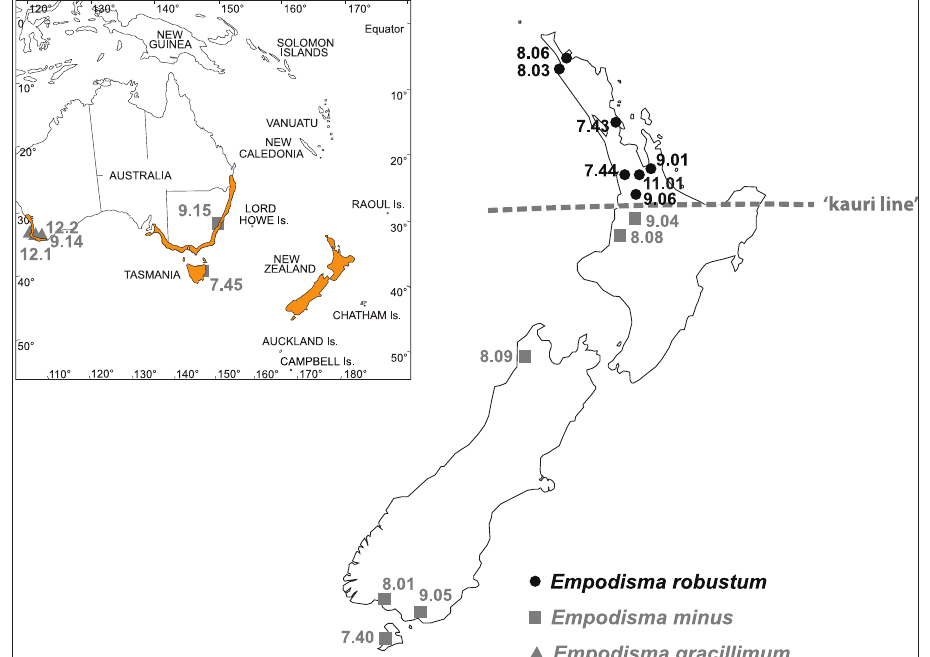
Figure 1. Map showing the generalized distribution of Empodisma in Australia and New Zealand and the collection localities of the DNA samples included in our study. The approximate position of the kauri line in New Zealand is shown with a dashed